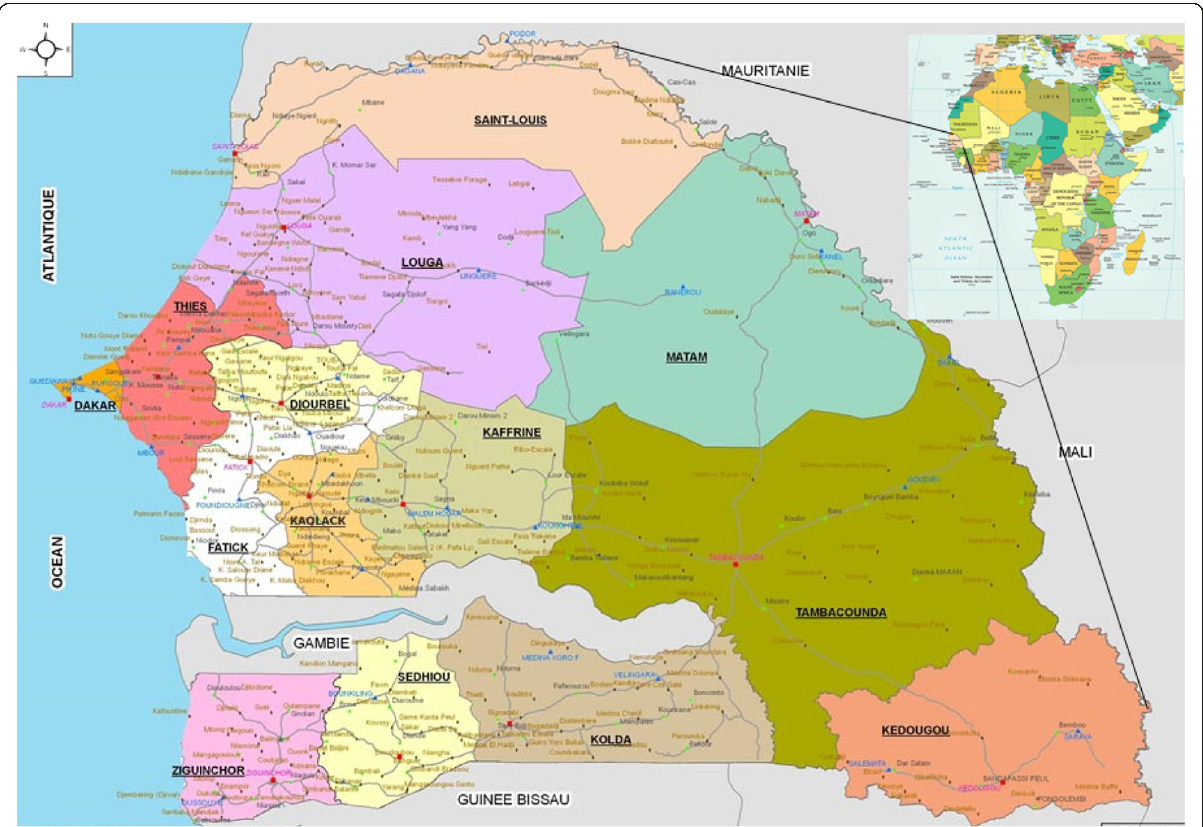
Fig. 1 Map of Senegal showing the survey